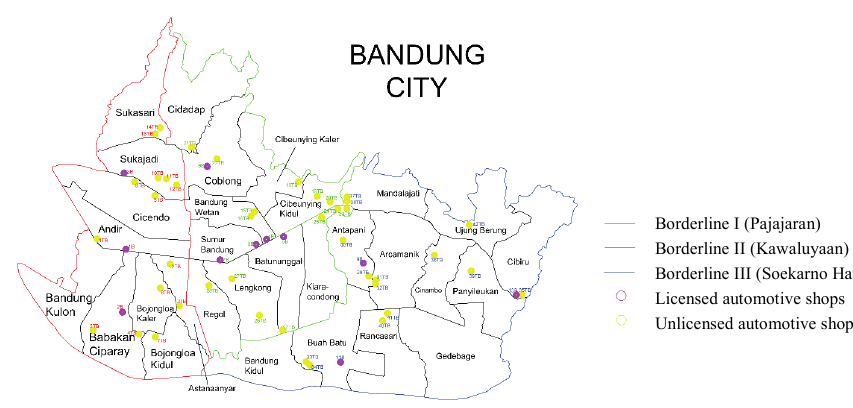
Fig. 1. Classification and sampling